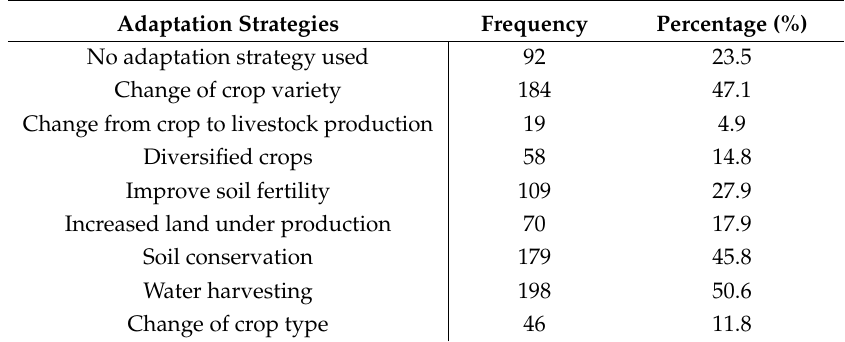
Table 5. Strategies used by smallholder farmers to cope with climate variability ( n = 391).